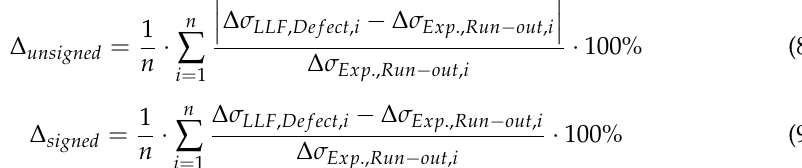
Table 7. Average deviations obtained by the applied assessment methodologies. ∆ [ % ] ∆ [ % ] unsigned signed R [ − ] SED TCD SED TCD − 1 8.6 11.3 +2.9 +9.2 0 7.0 7.4 +2.4